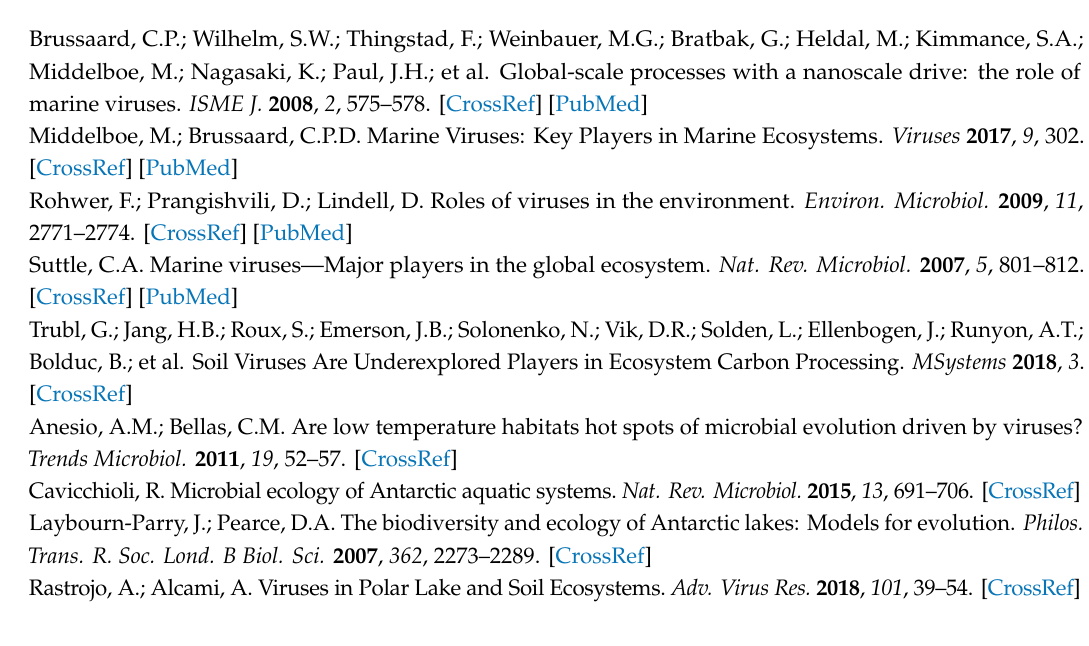
Figure S1: Sequence similarity network analysis of the Rep amino acid sequences encoded by viruses and viral-like circular molecules identified from cryoconite samples together with those of classified and unclassified CRESS viruses from